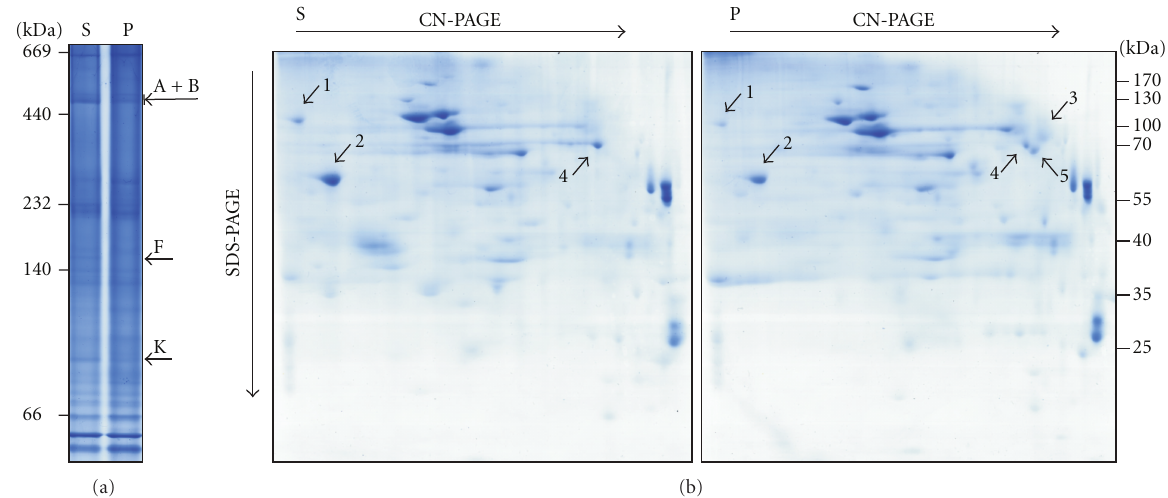
Figure 3: The protein complexes di ff erentially expressed between SW1990; and PANC-1 cell lines were labeled by A+B, F, and K in CN- PAGE (a). The proteins di ff erentially expressed between two cell lines in the second-dimensional SDS-PAGE were labeled in number (b) S: cell lysate of SW1990; P: cell lysate of PANC-1.